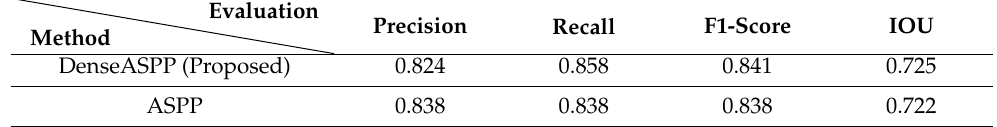
Table 7. Performance between model with DenseASPP and with ASPP.